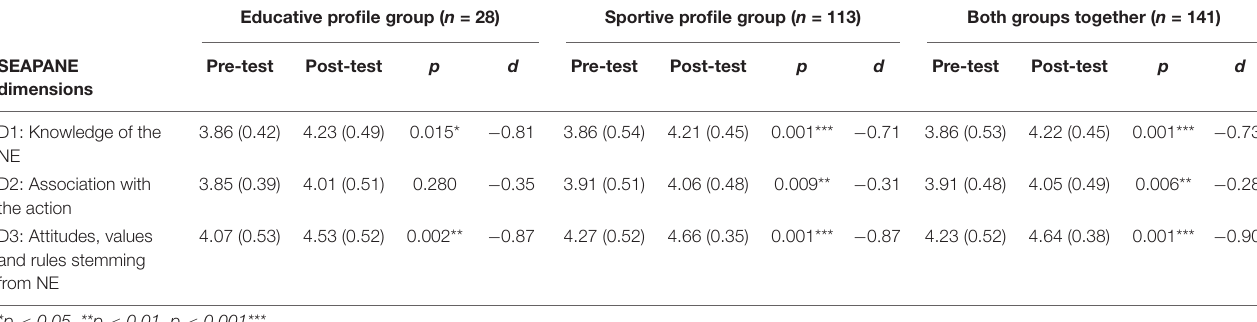
TABLE 2 | Analysis of Scale for Environmental Attitude in Physical Activities in Natural Environments (SEAPANE) in educative profile, sport profile, and both groups together. Educative profile group ( n = 28) Sportive profile group ( n = 113) Both groups together ( n = 141)